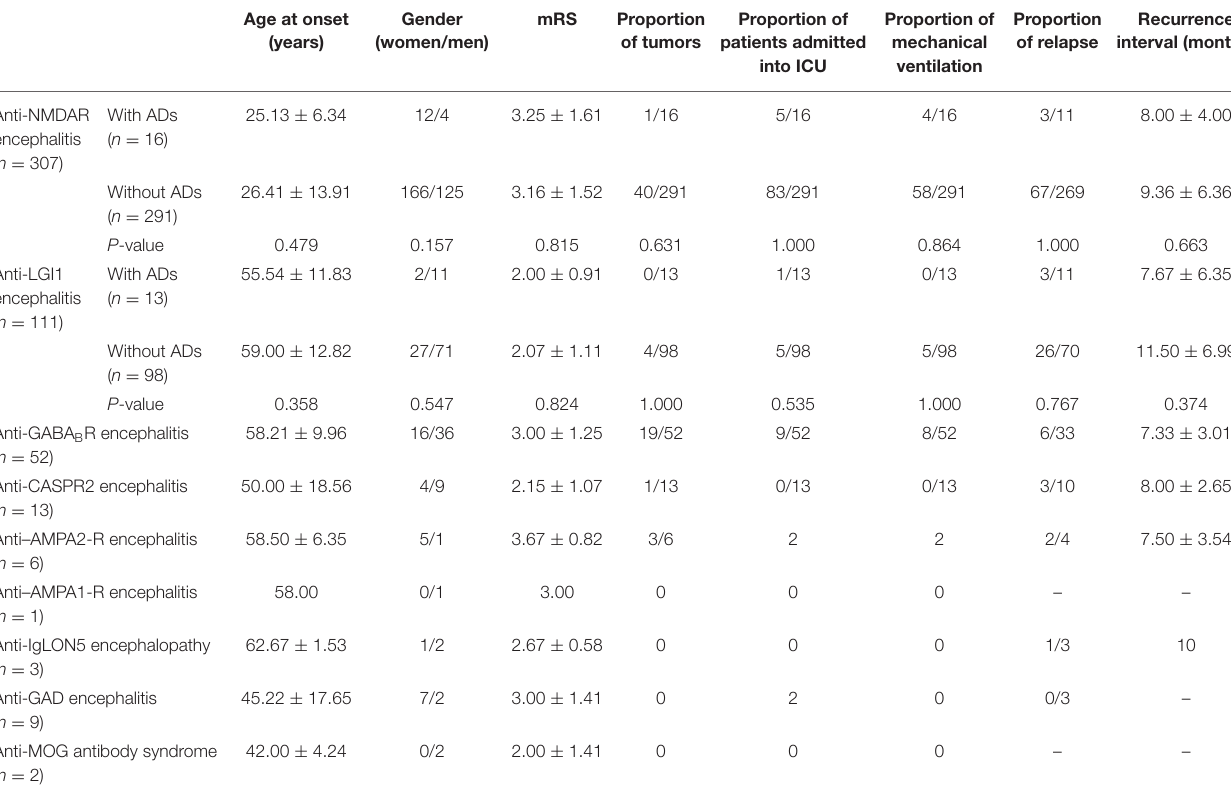
TABLE 1 | Clinical characteristics of AE patients and comparison of the clinical characteristics between the groups with and without coexisting ADs in anti-NMDAR and anti-LGI1 encephalitis patients.